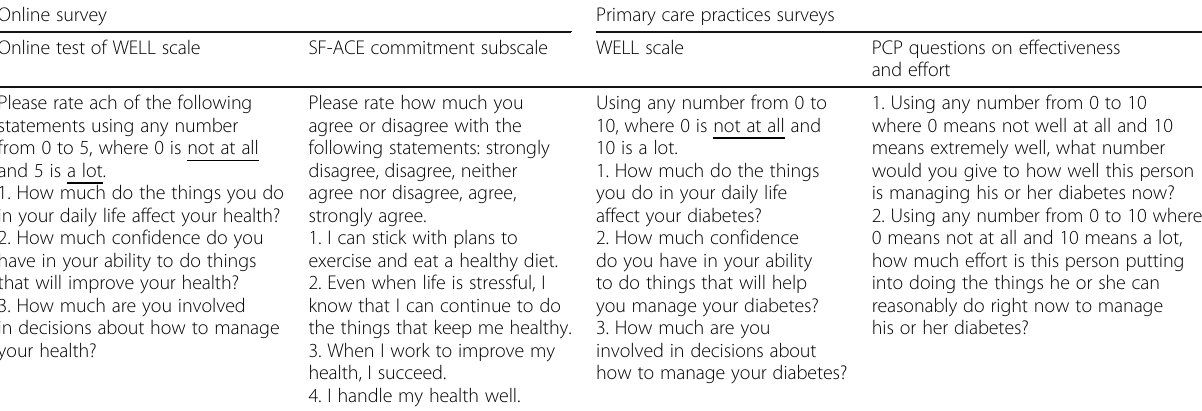
Table 1 Surveys used in the online and primary care practices studies Online